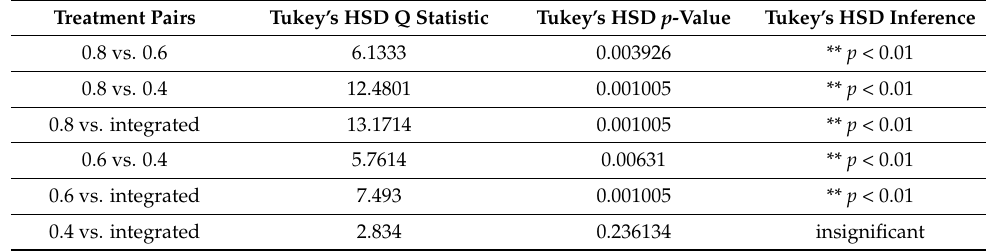
Table 8. Tukey’s honestly significant difference analysis results from phosphate datasets.